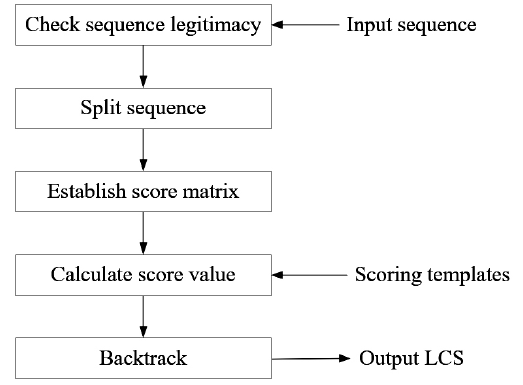
Fig. 3 Flow chart of LCS